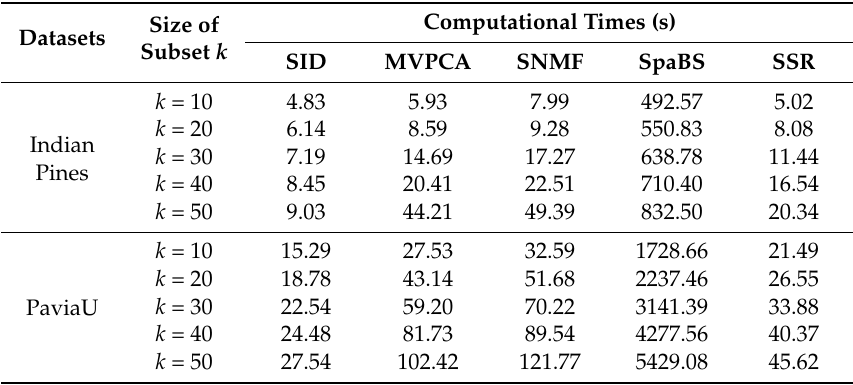
Table 6. Computational times of all five methods on both HSI